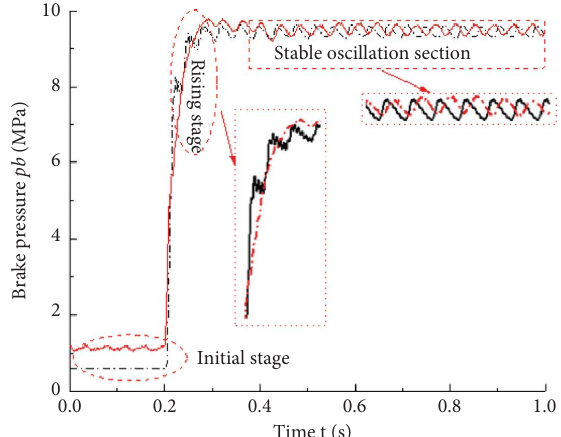
Figure 2: Te experimental results of servo valve pressure output.